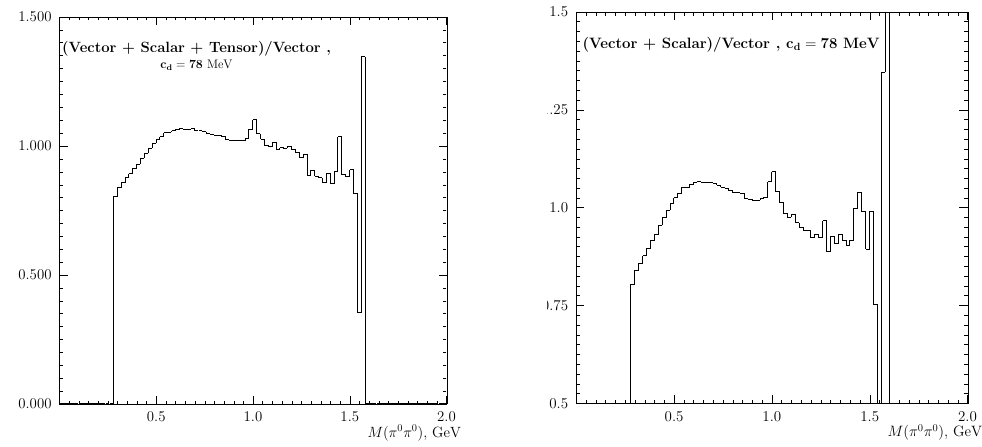
Figure 6 . a) Ratio of the vector+tensor+scalar and only vector √ s 3 = M π 0 π 0 spectral function for τ ν τ π 0 π 0 π − ; b) Ratio of vector+scalar and only vector. All the plots use the inputs in table 1 → except for c d , which is set to 78 MeV. The ratio vector+tensor/vector is independent of c d and is provided in figure